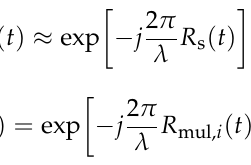
Figure 6. Azimuth multichannel reconstruction results in a distributed DPCMAB SAR system. ( a ) Azimuth spectrum without azimuth multichannel reconstruction; ( b ) azimuth compression result without azimuth multichannel reconstruction; ( c ) azimuth spectrum after conventional azimuth multichannel reconstruction; ( d ) azimuth compression result after conventional azimuth multichannel